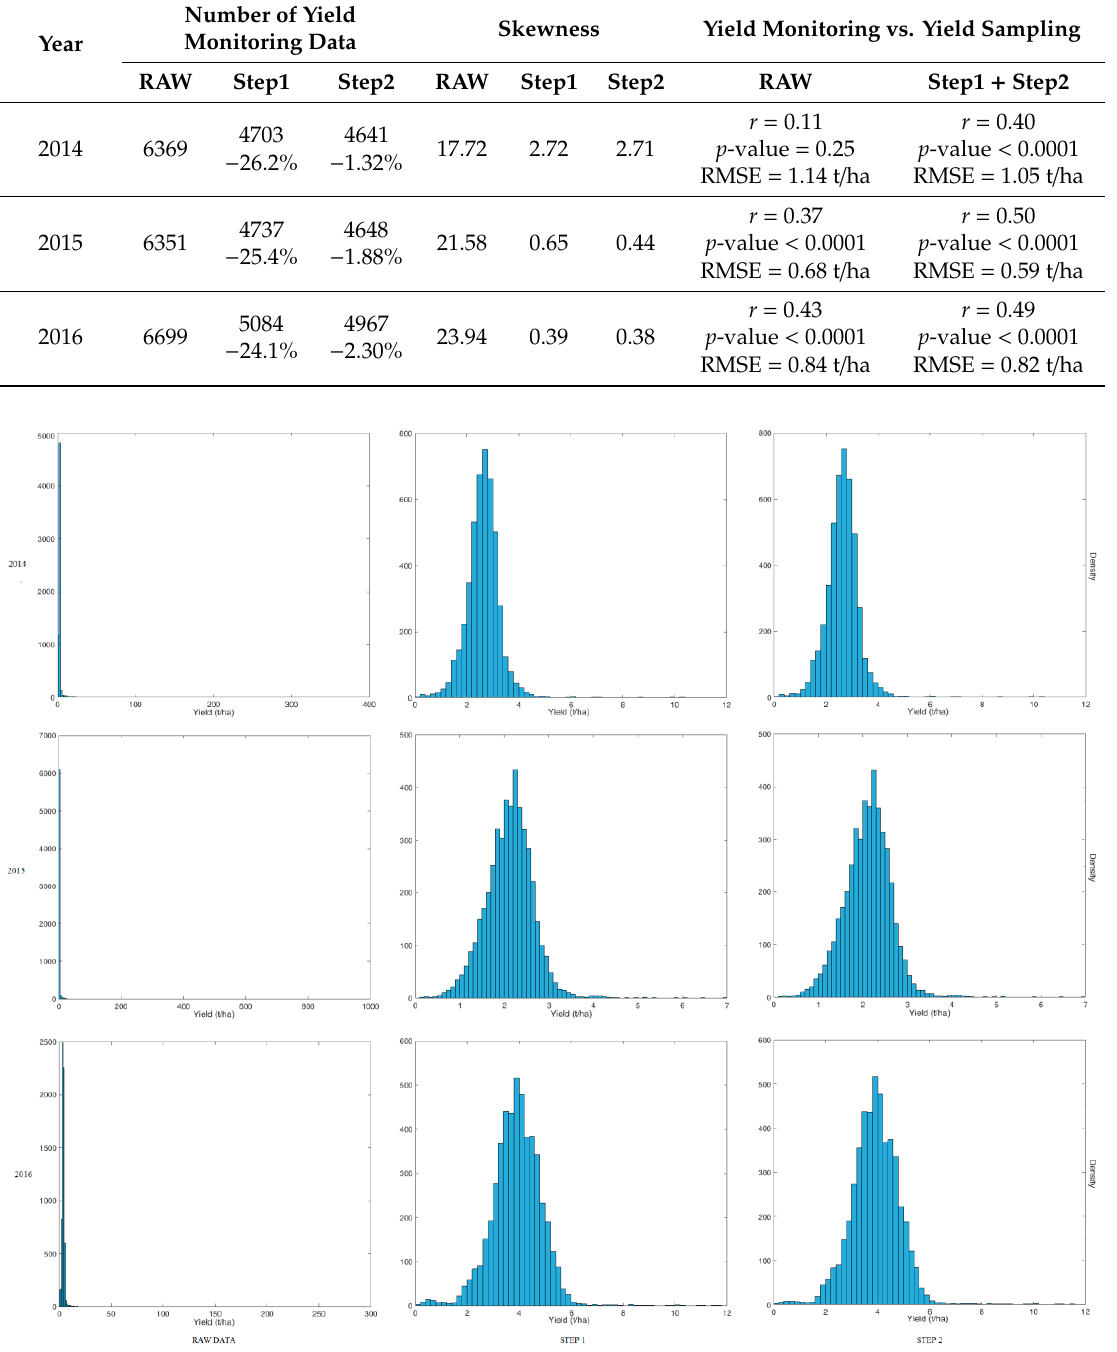
Table 2. Statistical features of yield monitoring datasets for uncleaned and cleaned yield data. Yield monitoring vs. yield sampling based on interpolated data.